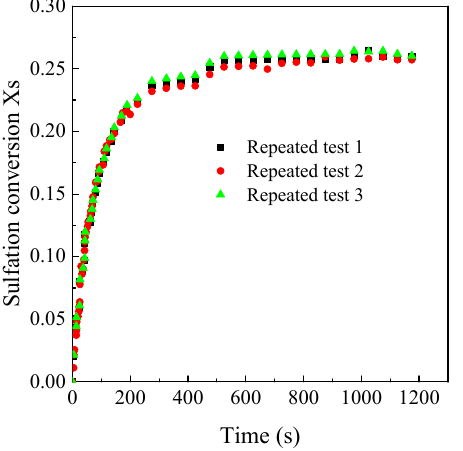
Figure 4. The sulfation conversion under different gas flow rate (Shengzhou limestone, 3.5 μ m, 850 °C, 500 ppm).